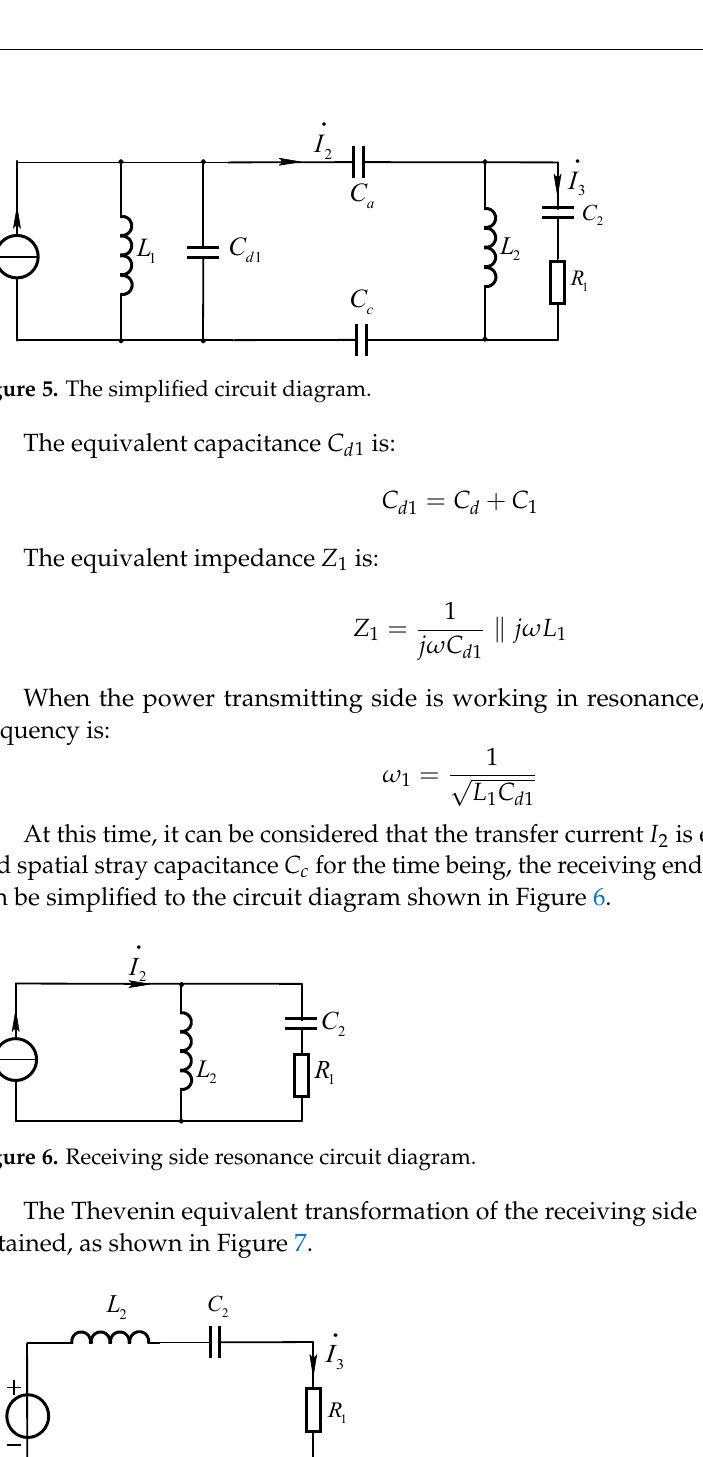
The current on the load is: